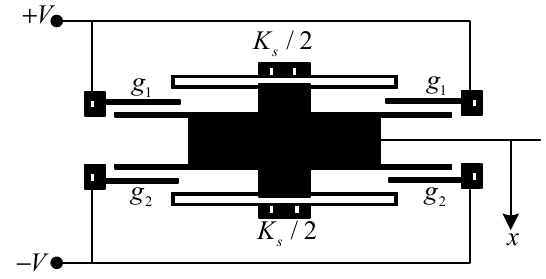
Figure 5. Simplified structure with average